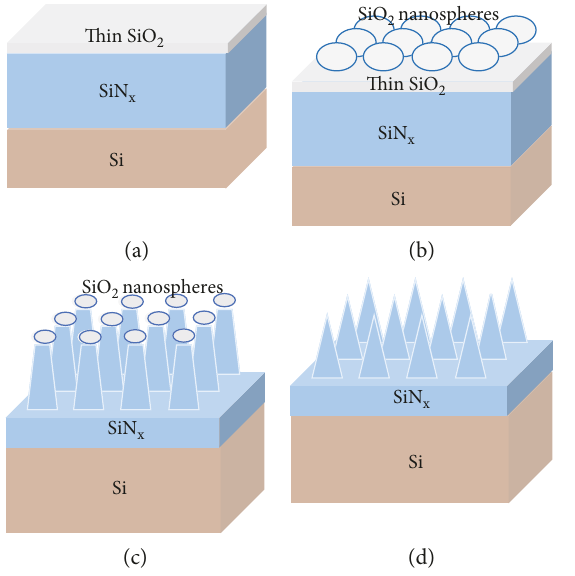
Figure 3: Fabrication process of the SiN layer on the c-Si, with a thin layer of SiO PECVD; (b) assemble a monolayer of silica nanospheres on top using LB coating method; (c) dry etch the SiN nanospheres as etching masks; and (d) remove the remaining silica nanospheres and SiO